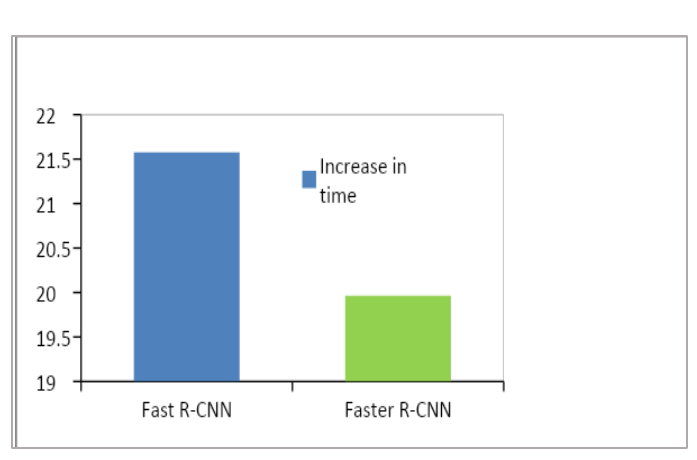
Figure 11. Comparison of